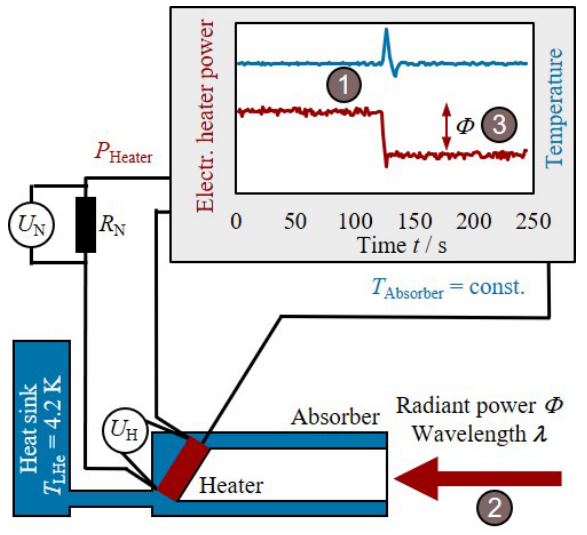
Figure 2. Measurement principle of the cryogenic electrical substi- tution